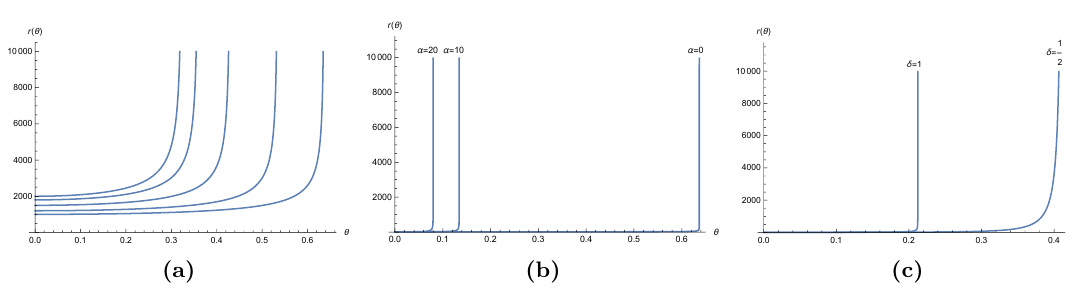
Figure 5. (a) β = 10 − 3 , α = 0 , δ = 1 . We see that higher values of θ 0 lead to smaller values of r 0 . (b) β = 10 − 1 , r 0 = 10 , δ = 1 . We see that higher values of α lead to lower values of θ 0 , for the same r 0 . (c) β = 10 − 1 , r 0 = 10 , α = 5 . Here we see that for the same r 0 and α a smaller value of δ leads to a higher θ 0